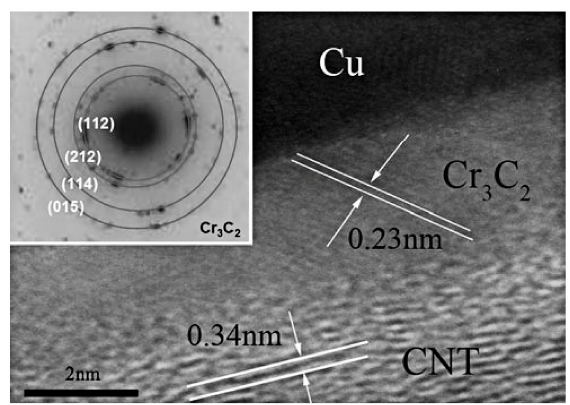
Figure 25. TEM image of Cr 3 C 2 precipitates at the CNT-(Cu-Cr) interface [150]. (Adapted with permission from [150], Springer, 2013.)